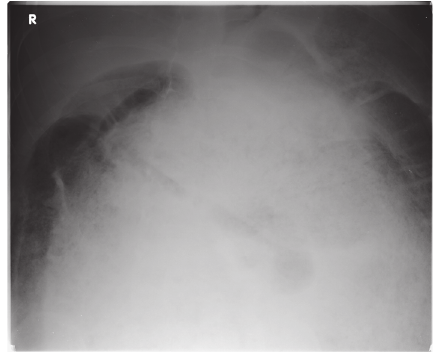
Figure 2: Plain preoperative erect chest